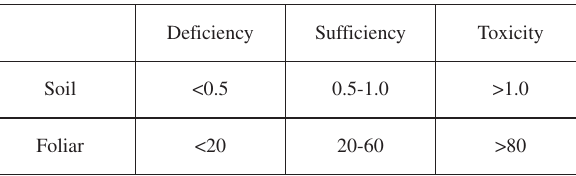
Table 4 : Range of Boron in soil and leaf tissues